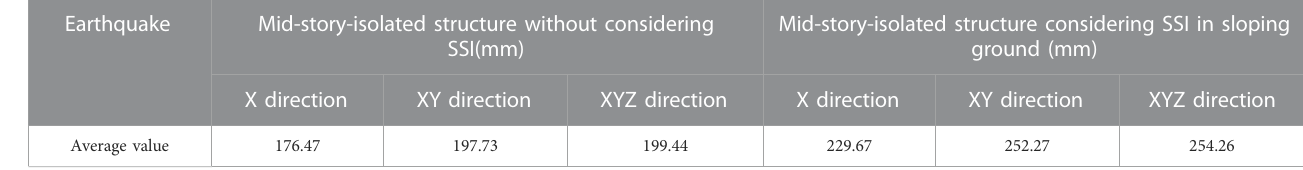
TABLE 7 Maximum displacement of isolated bearings.